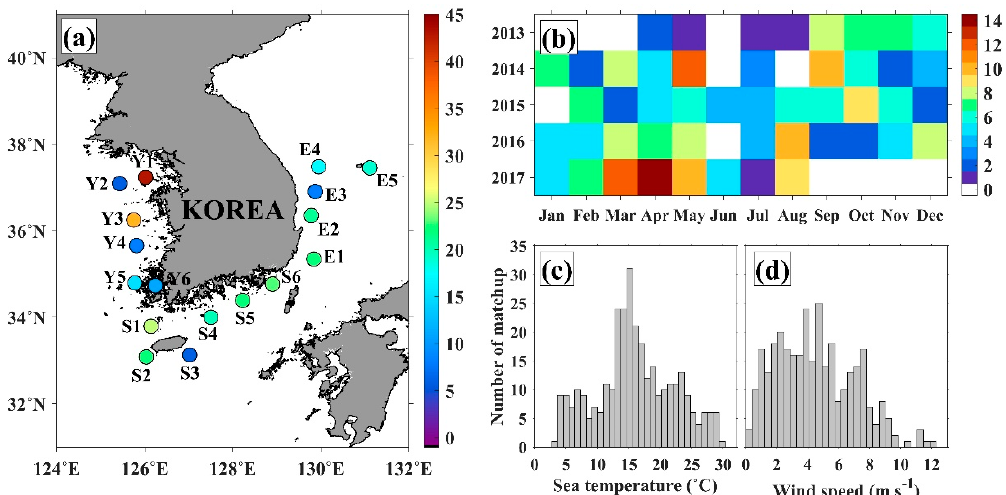
Figure 6. ( a ) The number of matchup data for each KMA marine meteorological buoy in the seas around the Korean Peninsula, ( b ) the number of Landsat 8 OLI / TIRS image acquisition from 1 April 2013 to 31 August 2017, and the histograms of the matchup data with respect to ( c ) sea temperature and ( d ) wind speed.